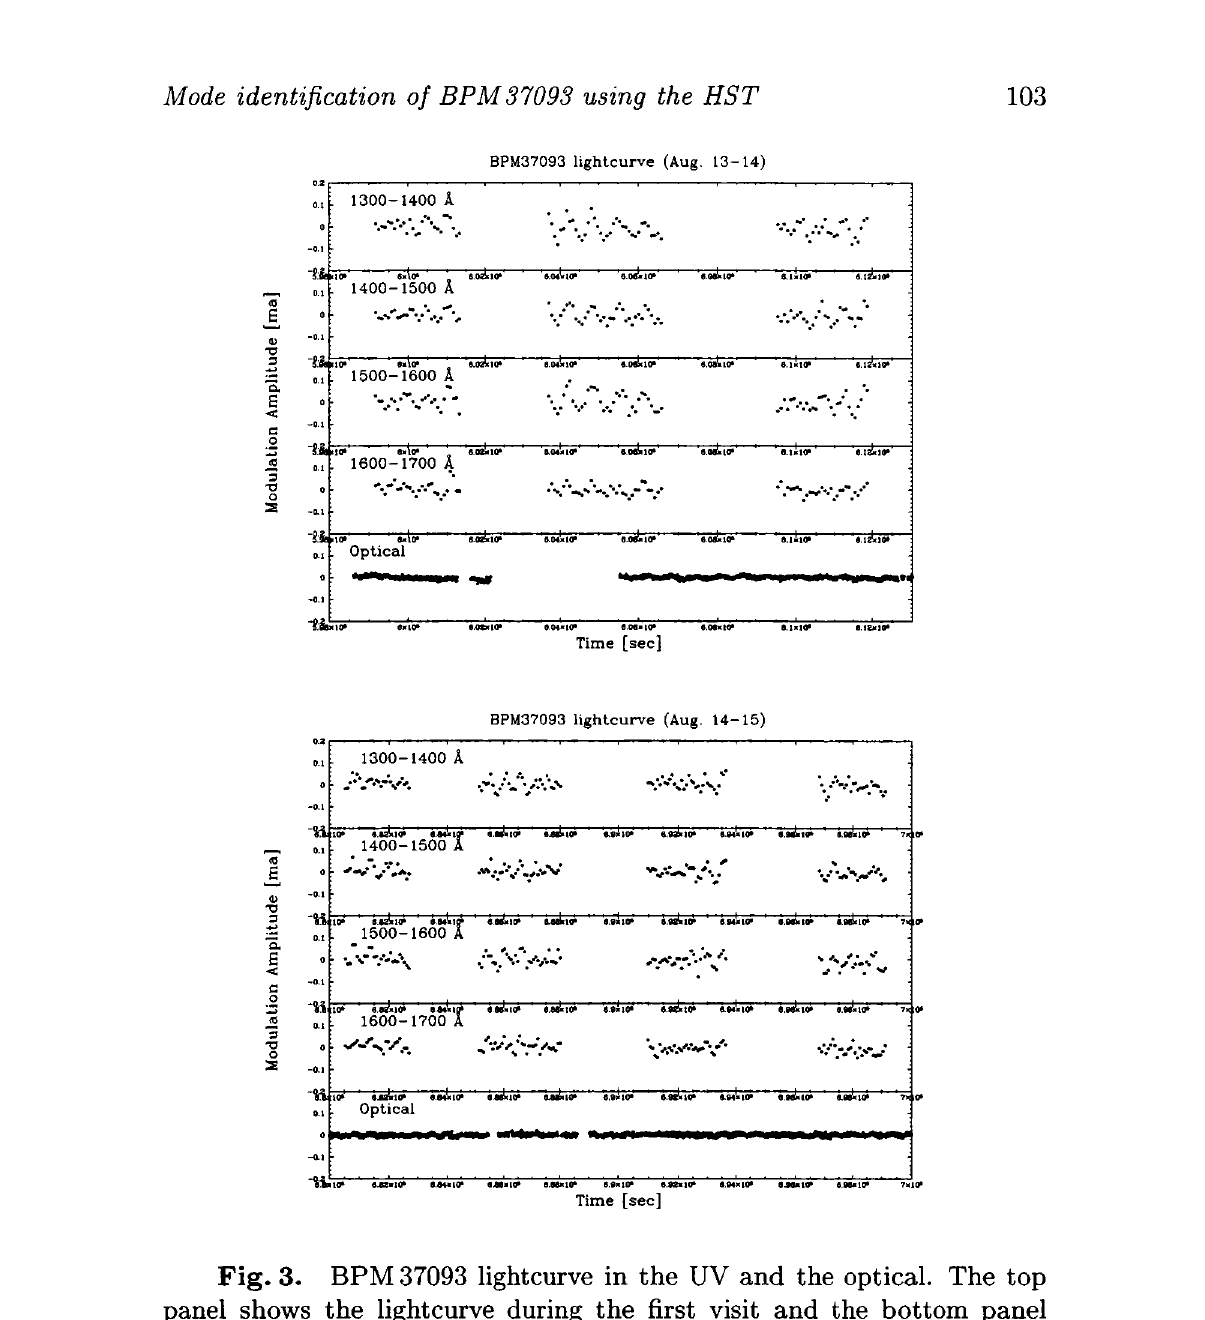
Fig. 3. BPM 37093 lightcurve in the UV and the optical. The top panel shows the lightcurve during the first visit and the bottom panel shows the light curve during the second visit. The vertical scale is the same for both panels. The amplitude is much higher in the UV, which is exactly what models show in Fig. 1. The density of points in the optical data is much higher because they were integrated for each 10 s, while the UV data were integrated over 80